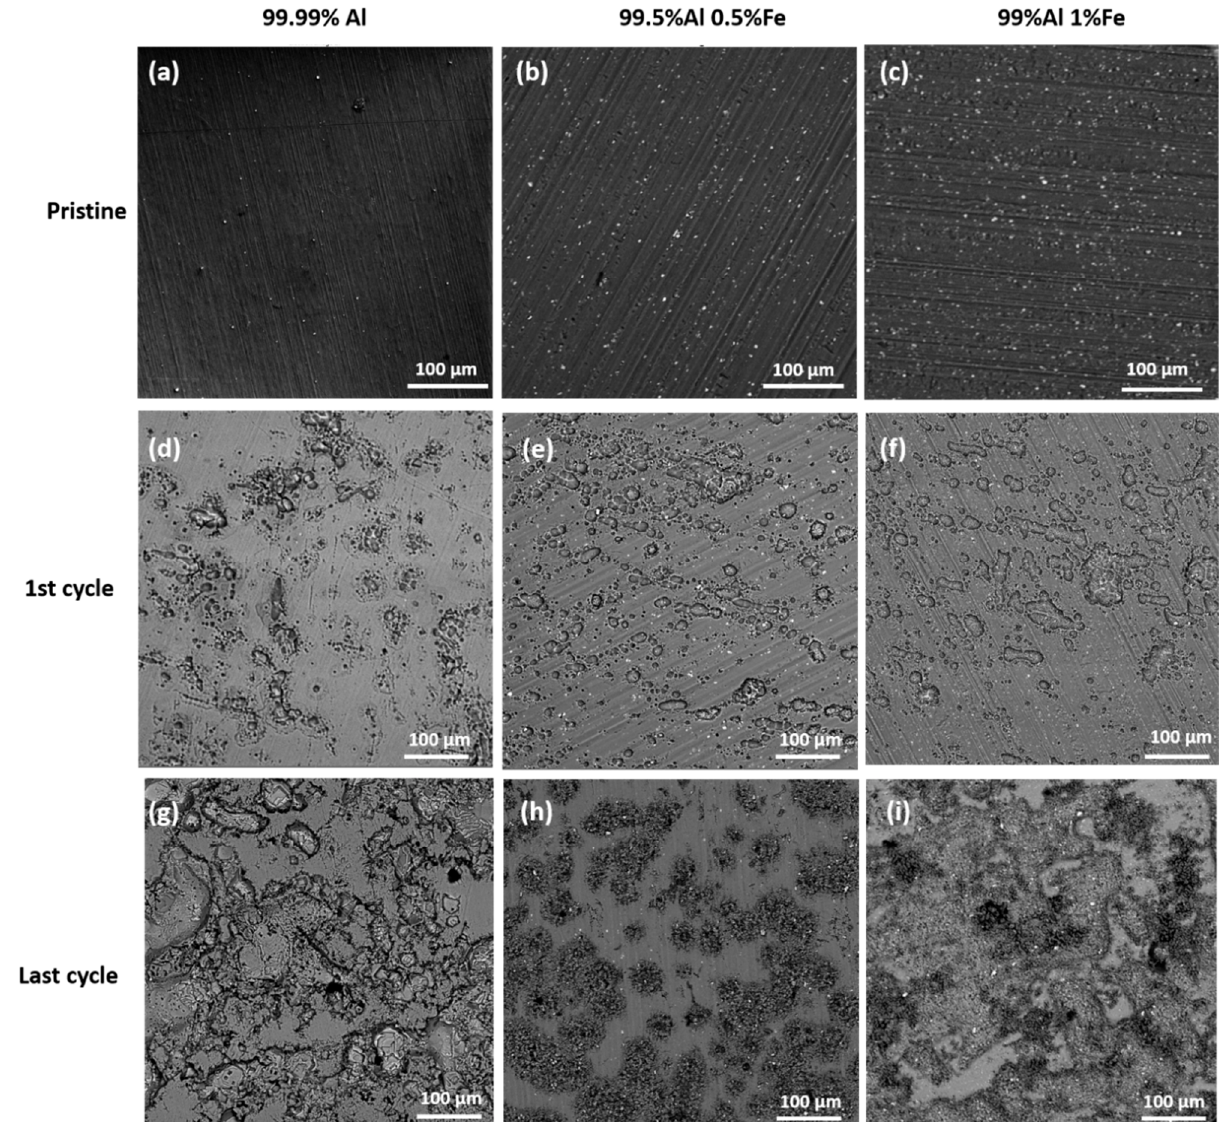
Figure 4. SEM backscattered images of pristine Al alloy surfaces: ( a ) 99.99% Al, ( b ) 99.5% Al 0.5% Fe, ( c ) 99% Al, 1% Fe. SEM backscattered images from Al alloy anodes surfaces after first charge–discharge cycles: ( d ) 99.99% Al, ( e ) 99.5% Al 0.5% Fe, ( f ) 99% Al 1% Fe. SEM images of the Al alloy anode surfaces from last charge–discharge cycles: ( g ) 99.99% Al, ( h ) 99.5% Al 0.5% Fe, ( i ) 99% Al 1% Fe.